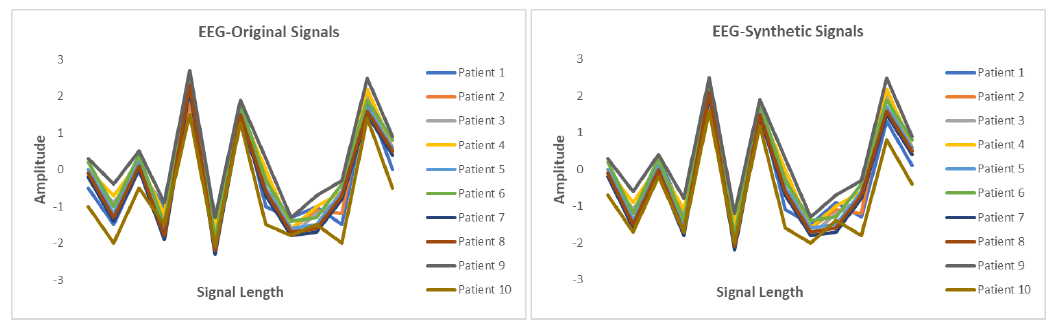
Figure 10. Comparison between original and synthetic EEG signals.